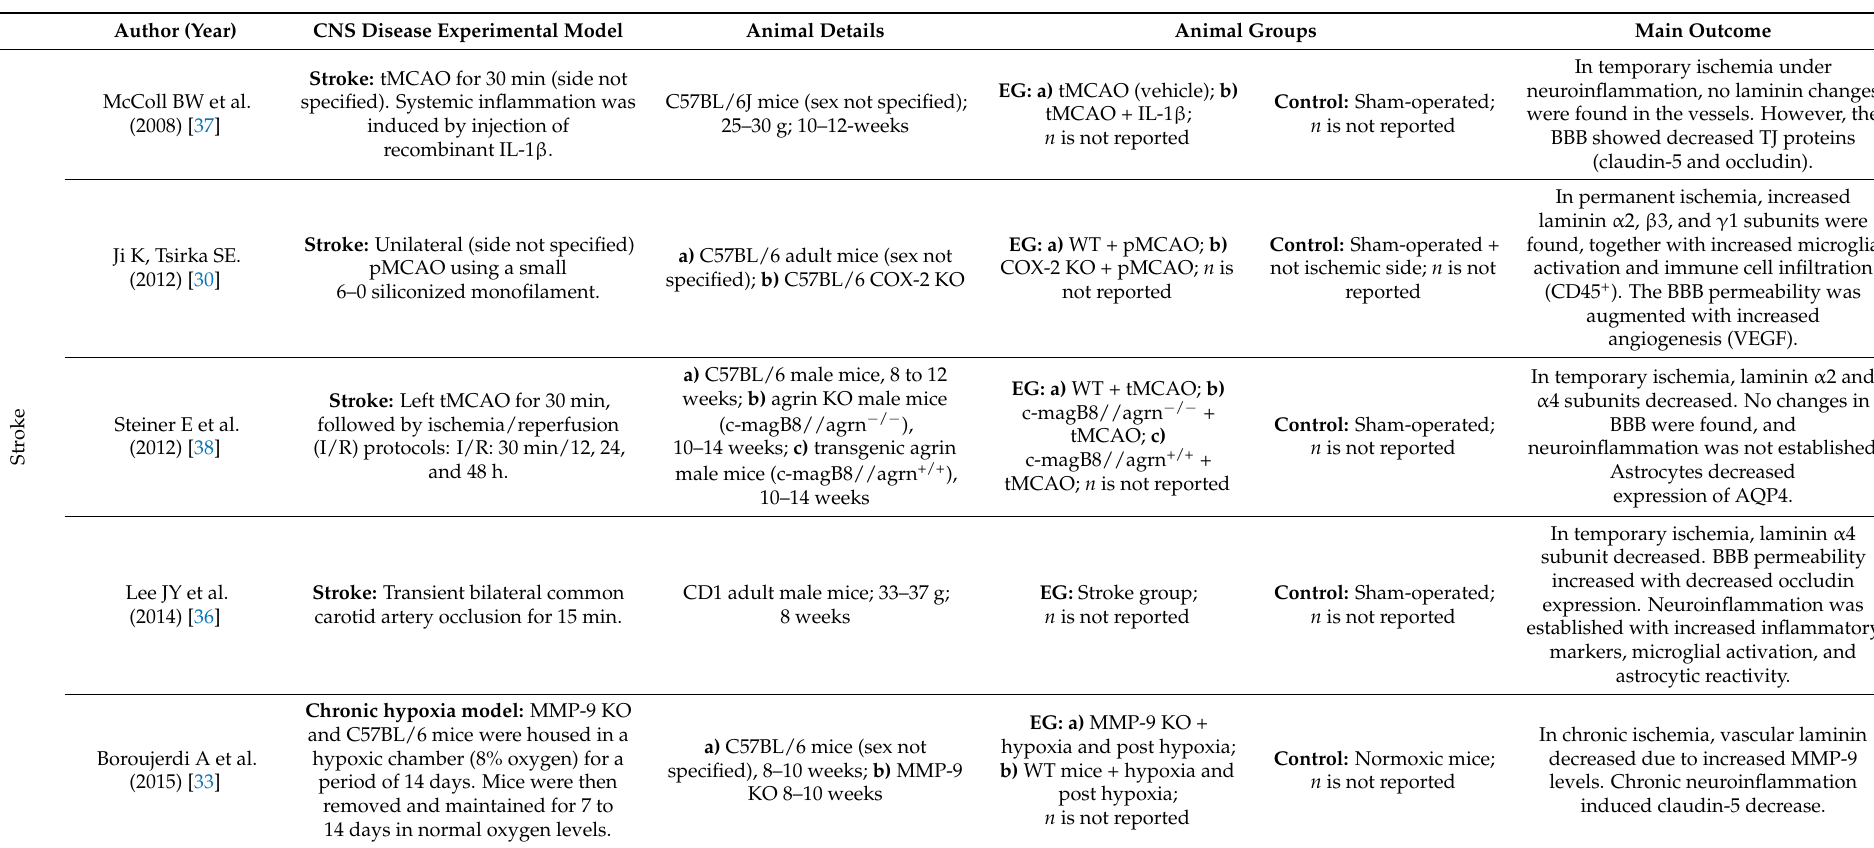
Table 1. General characteristics of the included